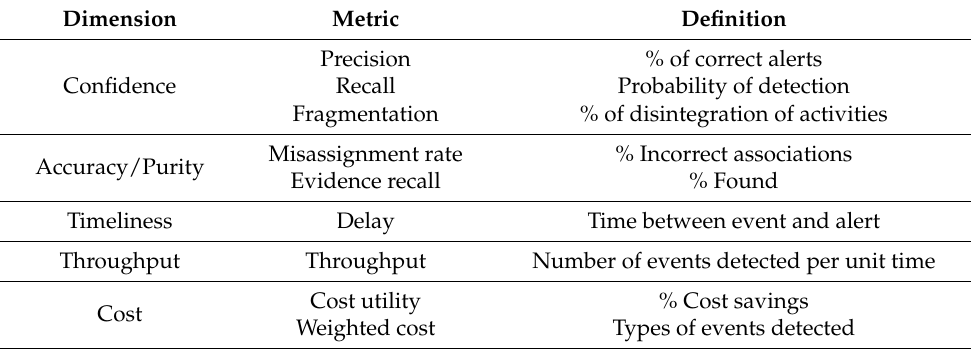
Table 2. Situational awareness system